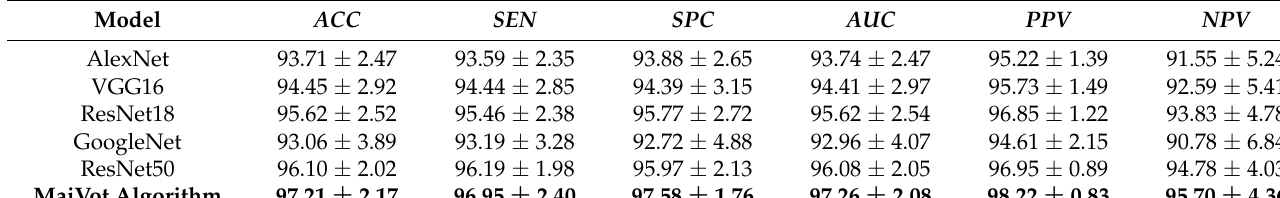
Figure 15. The accuracy improvement of the MajVot algorithm against the other five models on three datasets.